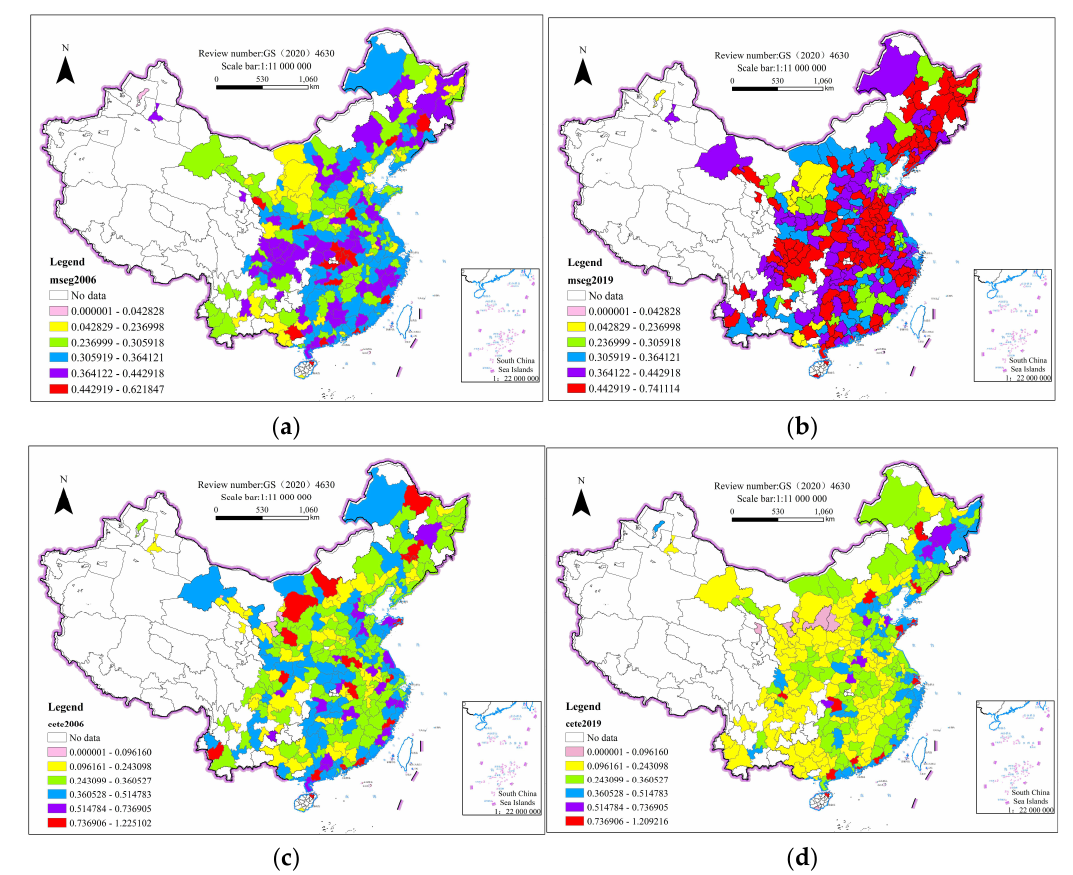
Figure 2. Spatial and temporal quantile of green development performance of 282 cities in China.